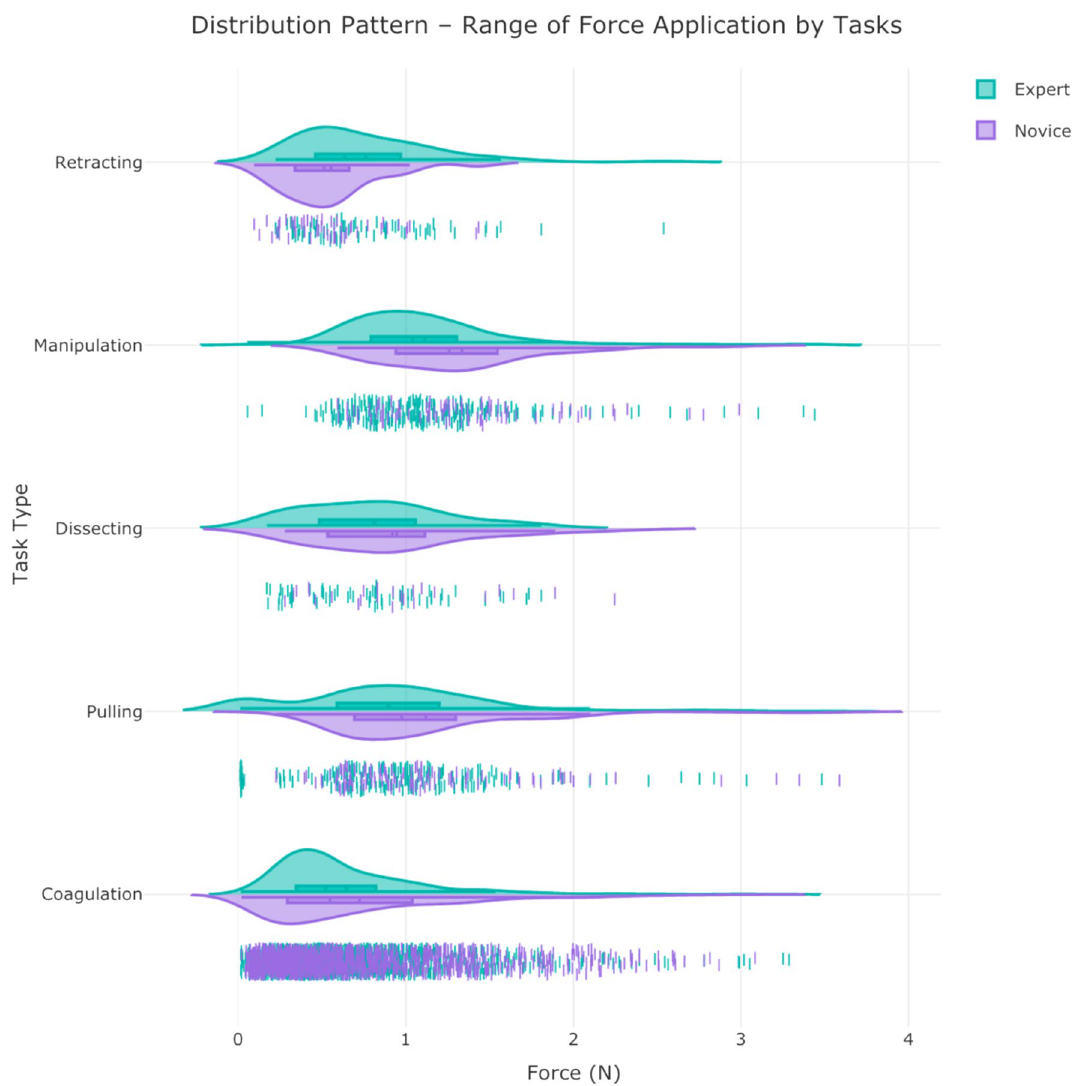
Figure 6. Aggregative data distribution of both Expert (green violin plots) and Novice (purple violin plots) surgeons across the surgical tasks for each time-series extracted feature (Force Range in this sample graph). Detailed statistical information including min, max, median, mean, q1, and q3 are available to view on mouse hover in the original app and the Supplementary Material. Figure created by R Plotly library version 2.0: https:// plotly.